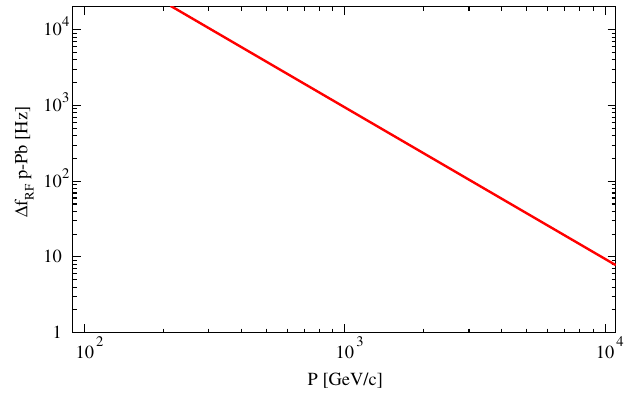
FIG. 8. Expected central rf frequency difference between proton and Pb 82 þ beams as a function of the beam momentum at the LHC.